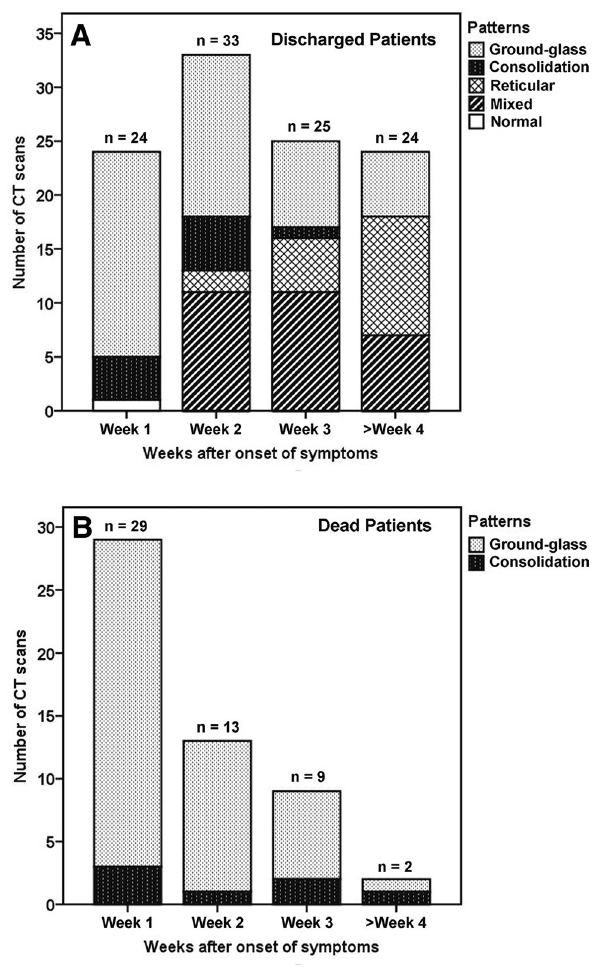
Figure 2. Stacked-bar graphs show distribution of various patterns of lung abnormalities in discharged (A) and dead patients (B) on CT scans at different time points after onset of